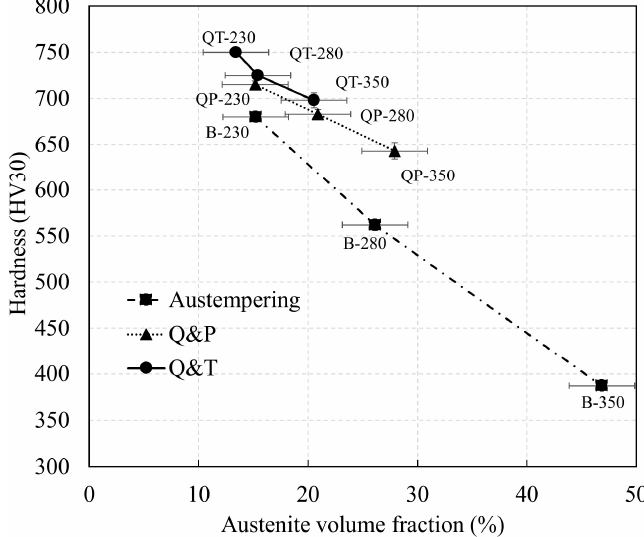
Figure 4. Hardness measurements of bainitic and Q&P and Q&T martensitic structures in Nanobain bearing steel as a function of the retained austenite volume fraction, as measured by XRD.